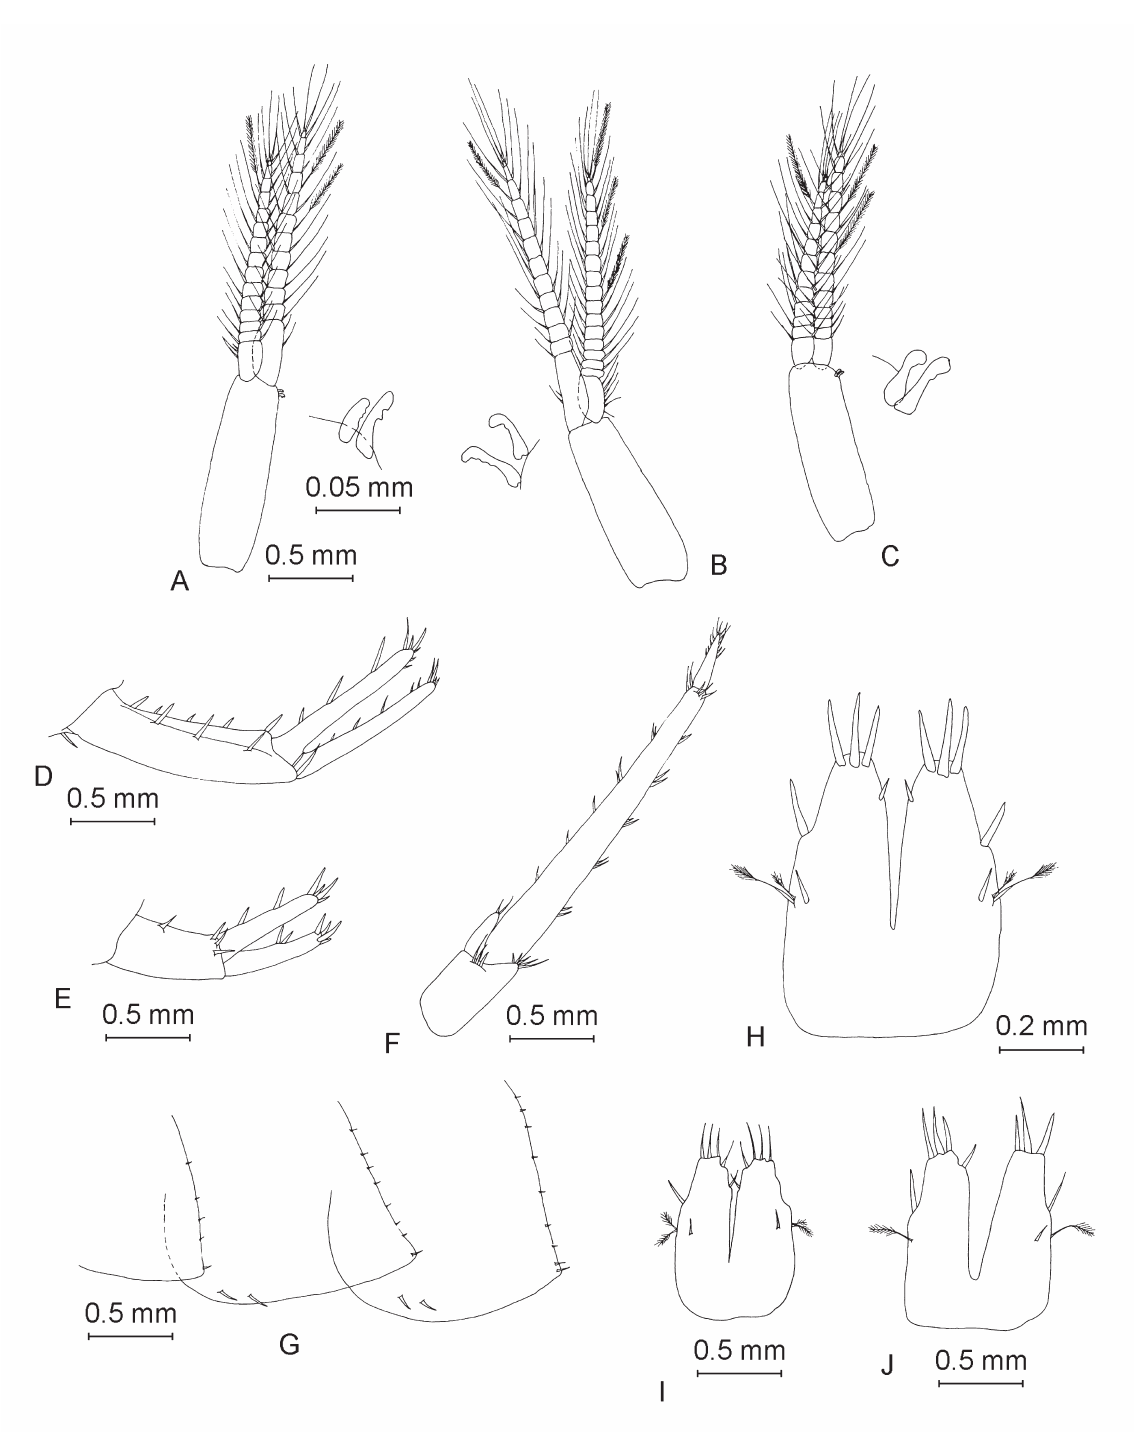
Fig. 14. — A–H . ♀. A . Pleopod I (with detail of retinacles). B . Pleopod II (with detail of retinacles). C . Pleopod III (with detail of retinacles). D . Uropod I. E . Uropod II. F . Uropod III. G . Epimeral plates. H . Telson. — I . Telson of ♂ sampled from str. Avram Iancu 26. J . Telson of ♀ sampled from str. Crinului